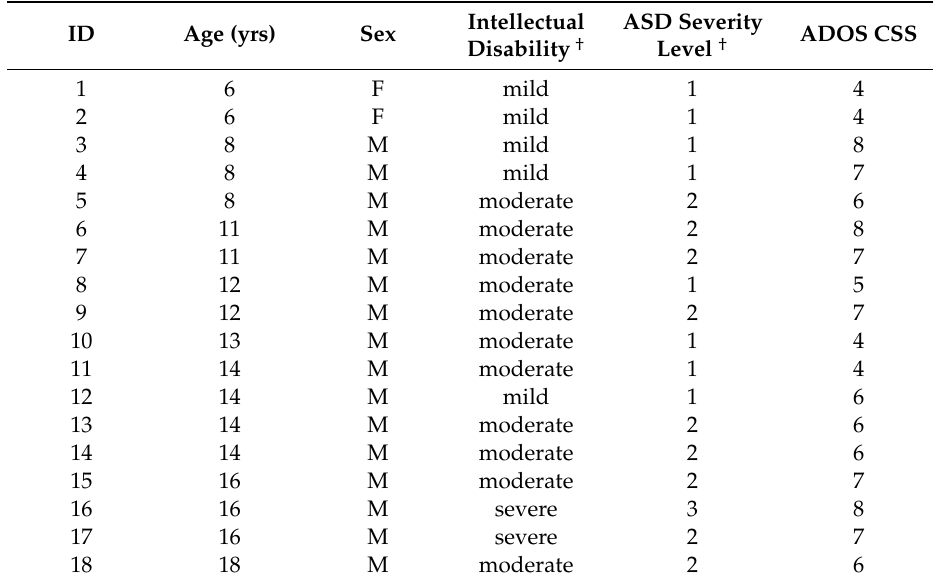
Table 1. Demographic and clinical characteristics of ASD